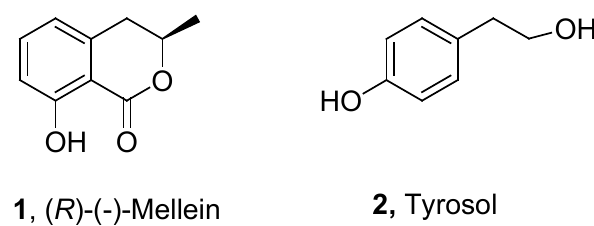
Figure 1. Structures of R (-)-mellein 1 and tyrosol 2 isolated from Lasiodiplodia laeliocattleyae